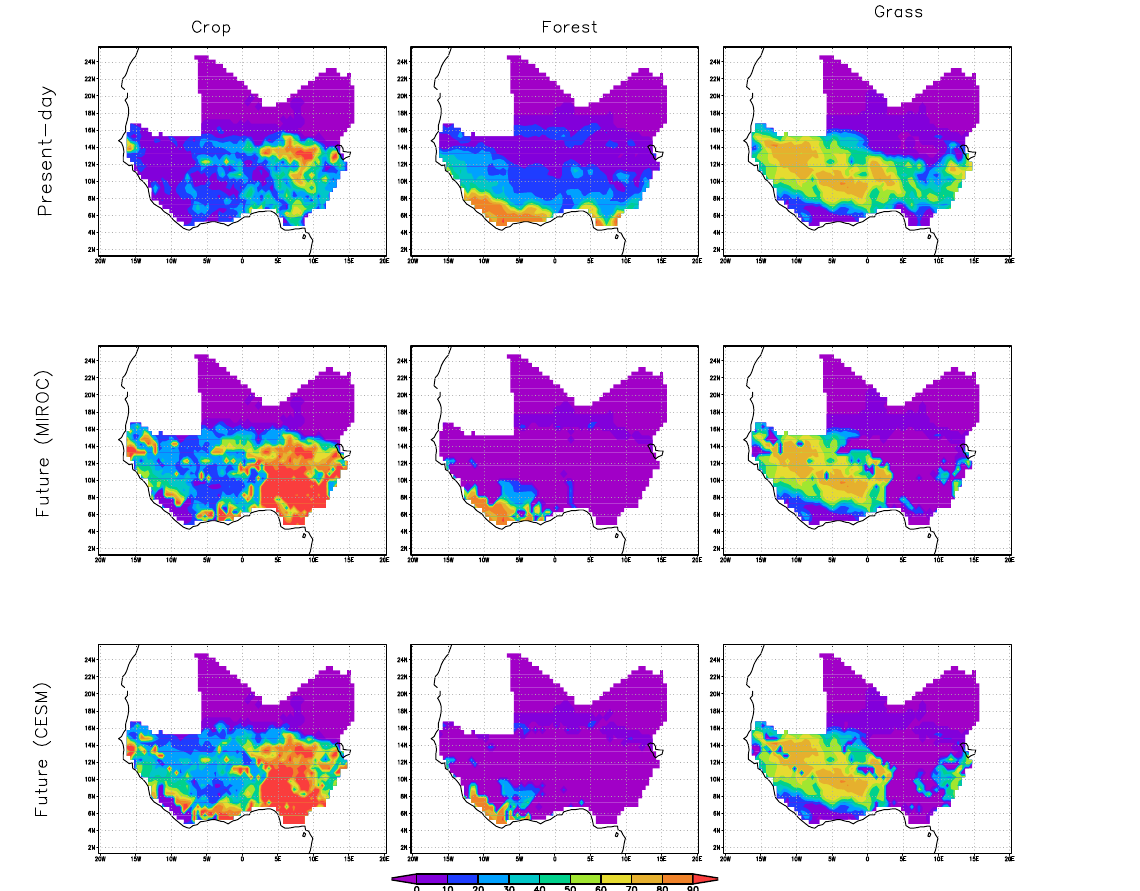
Figure 1. Spatial distribution of cropland, forest, and grass coverage (%) in 14 West African countries from present-day (year 2005) obser- vation (top row panels) and future projections by the LandPro for mid-21st century under regional climates driven with two GCMs: MIROC (middle row panels) and CESM (bottom row